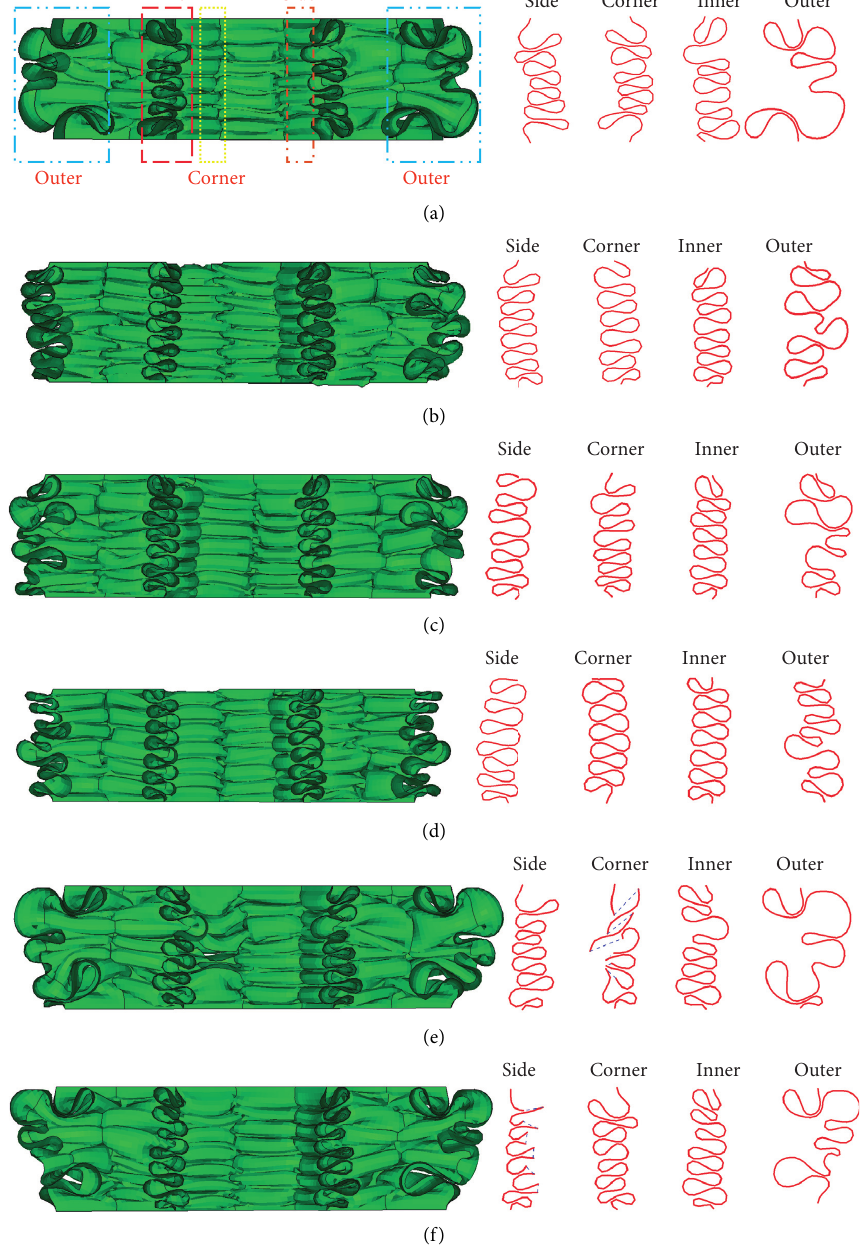
Figure 10: Comparison of the deformation modes of the different windowed structures. (a) MC. (b) MCS-C. (c) MCS-S. (d) MCS-M. (e) MCC-C. (f)